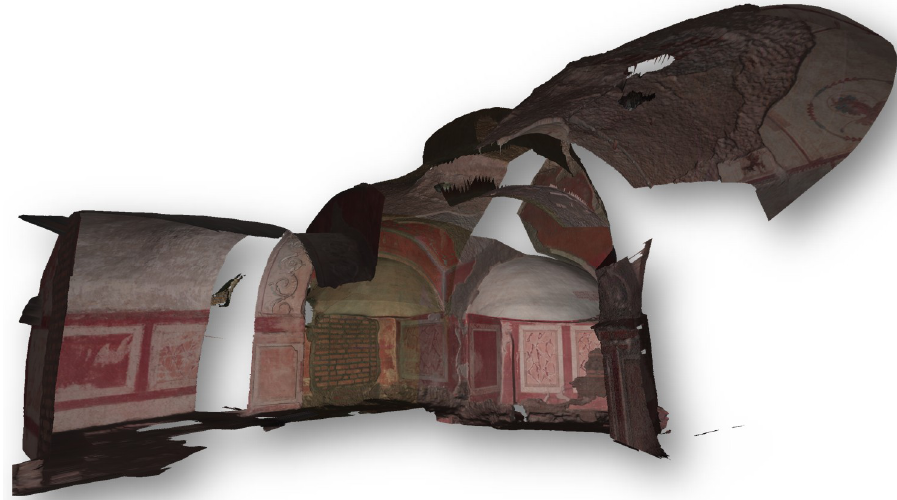
Figure 12. 3D partial model of the Greek Chapel reporting truthful colors. (Elaboration carried out by ENEA team with the custom software itrAnalyzer).